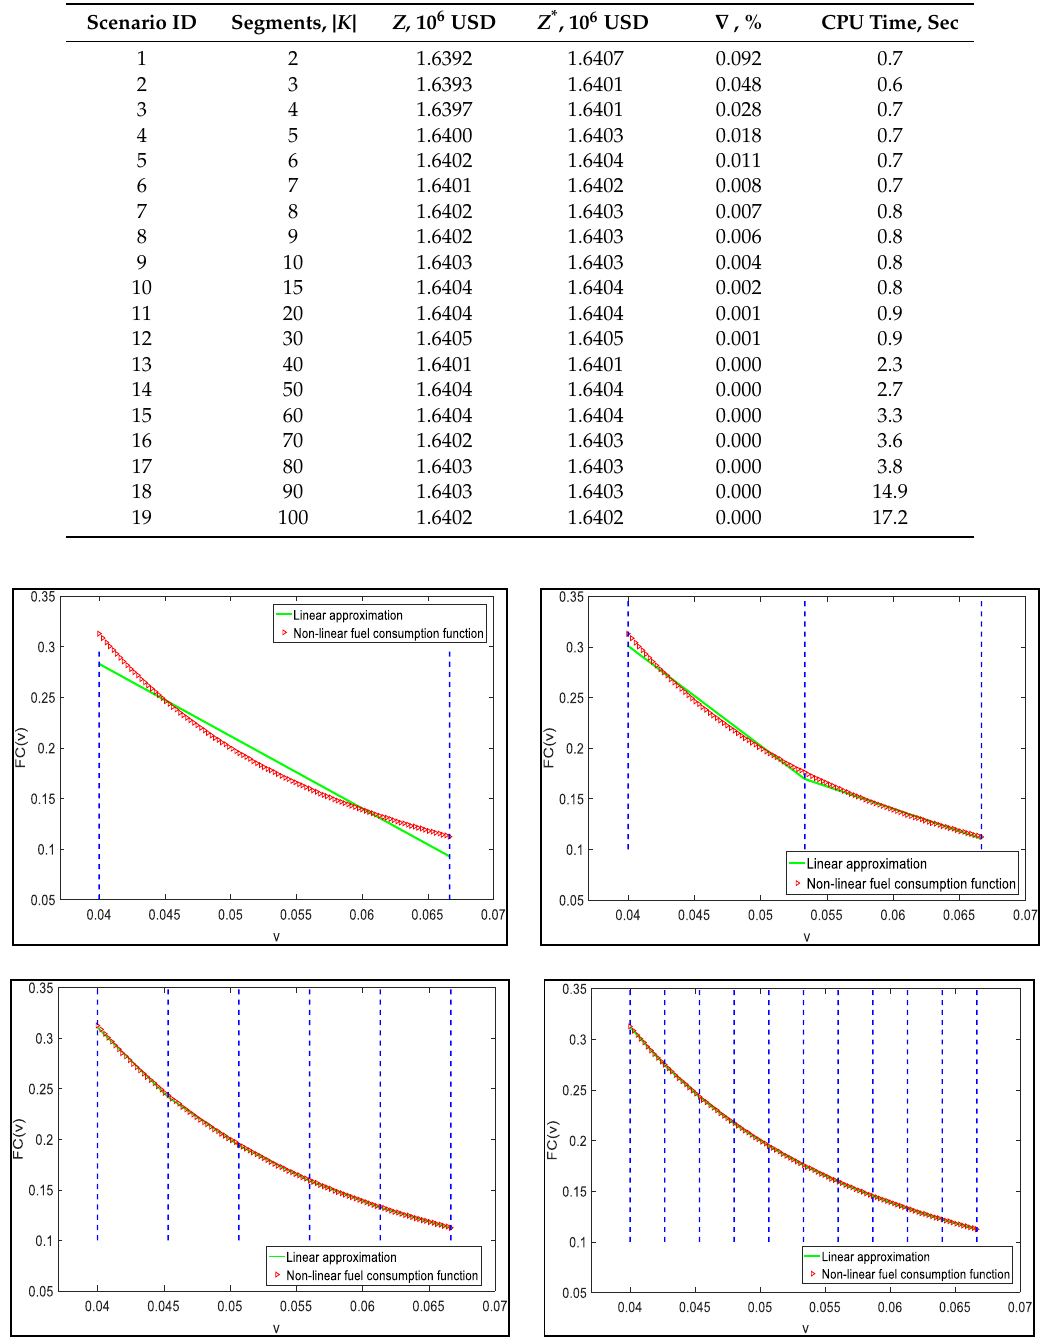
Table A1. The piecewise approximation analysis results.